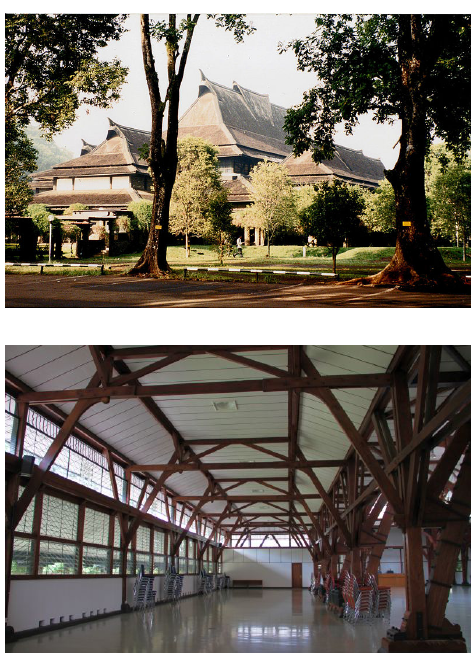
Figure 1. Photographs of ”Aula Barat” building,